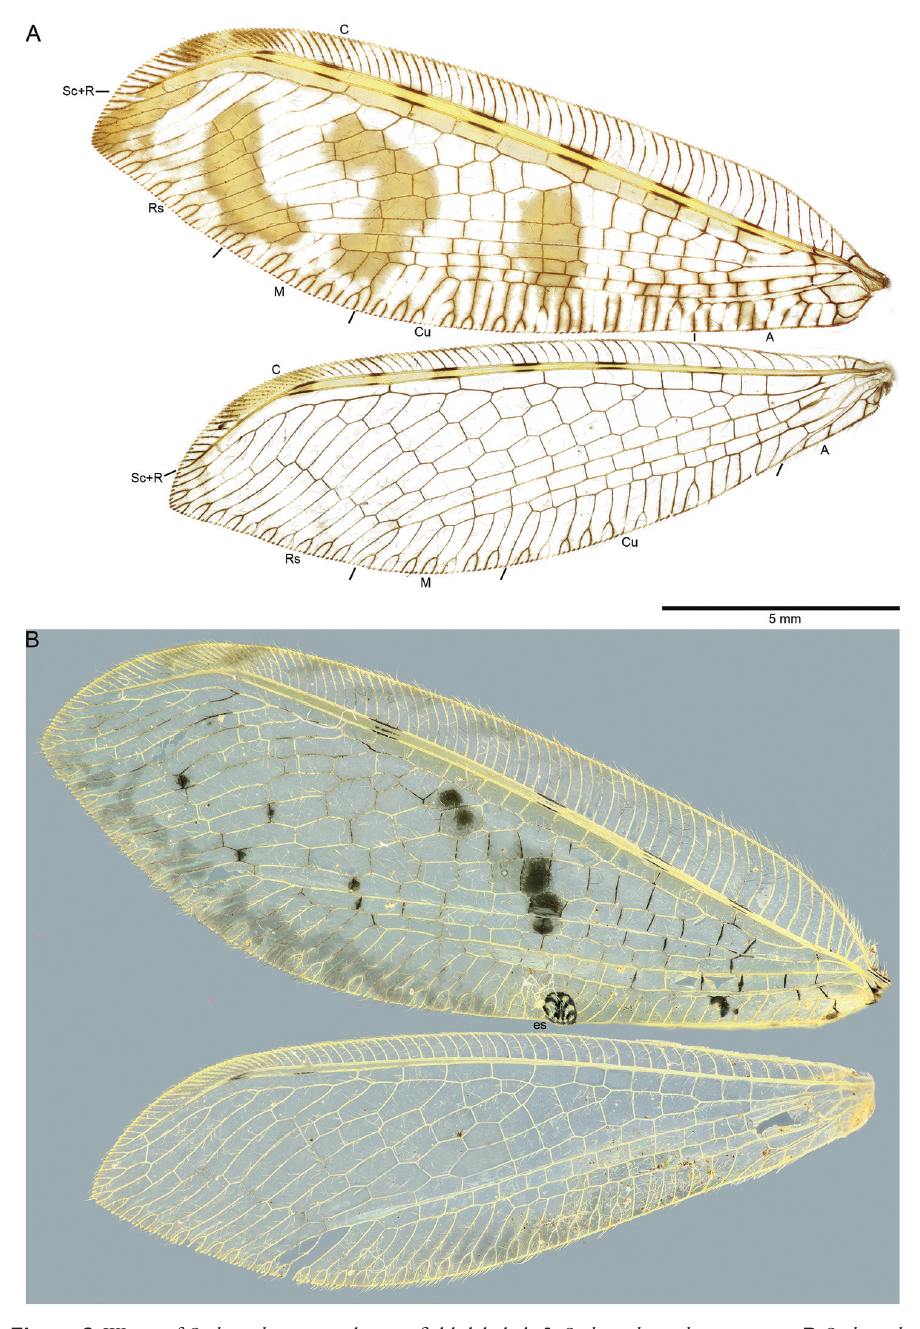
Figure 2. Wings of Spilosmylus spp. with main fields labeled: A Spilosmylus spilopteryx sp. n. B Spilosmylus tephrodestigma sp. n. Abbreviations: C, Costa; Sc, Subcosta; R, radius; Rs, Radius sector; M, Media; Cu, Cubitus; A, Anal field; es, embossed